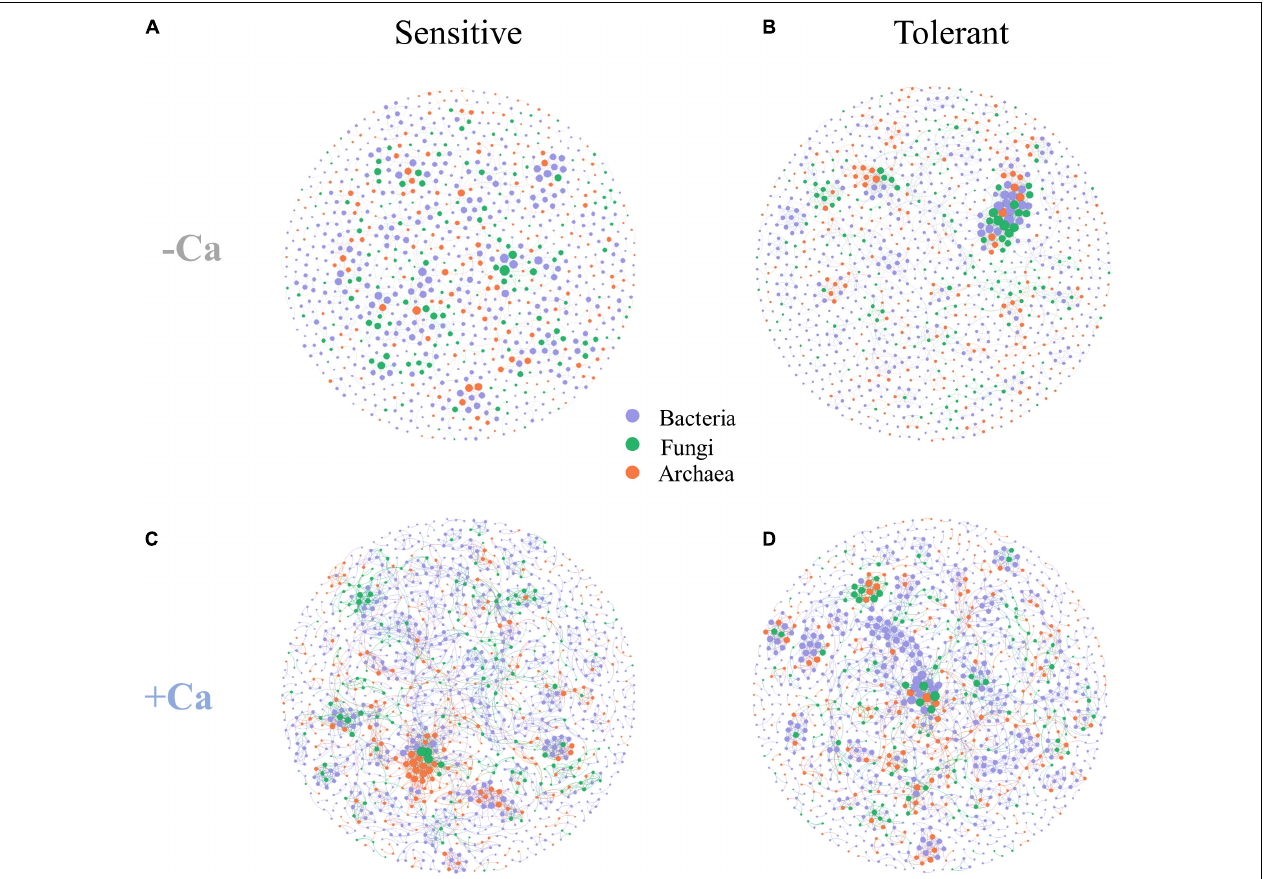
FIGURE 7 | Co-occurrence networks of archaeal, bacterial, and fungal communities for Al-sensitive (A,C) and Al-tolerant (B,D) rice genotypes in acid sulfate soils under liming and non-liming conditions. The size of each node is proportional to the number of connections. The archaeal, bacterial, and fungal ASVs are indicated in orange, purple, and green, respectively.